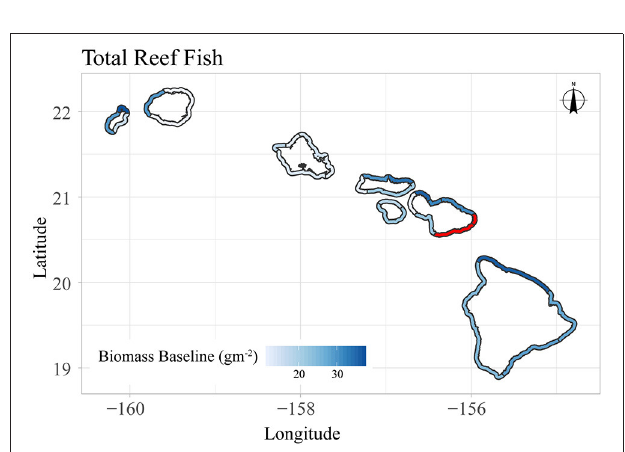
FIGURE 9 | Map of sector-level, mean baseline biomass for total reef fish in the main Hawaiian Islands. Sectors with limited data are shown in red.